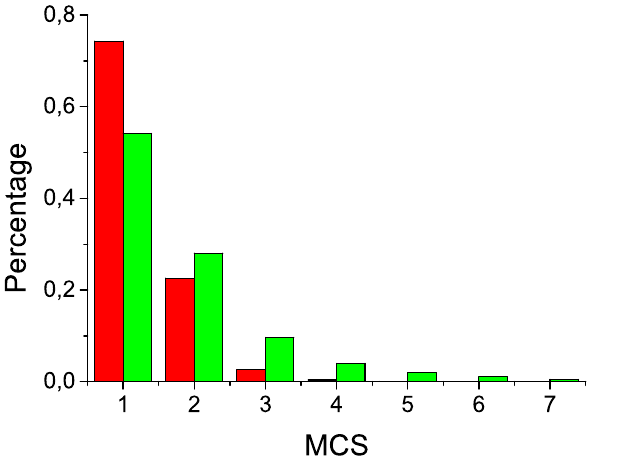
Figure 4. The histogram compares the numbers of Monte Carlo steps on 11 × 11 lattice that particle A needs to reach the four-cite border of cluster in the case of 0.45 substrate coverage with A only (red) and 0.9 substrate coverage with A + B (green); averaged over 10 6 runs.